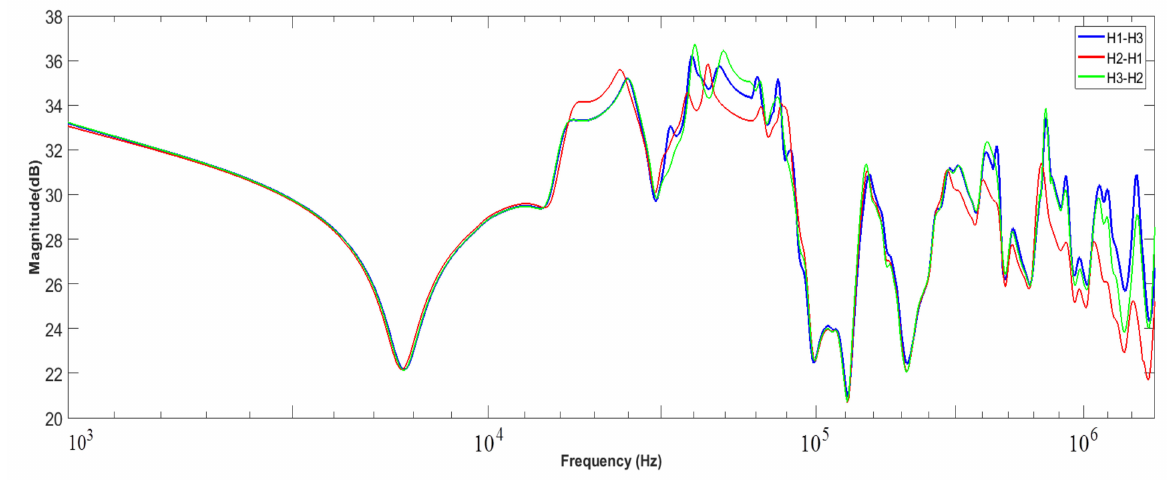
Figure 17. Frequency response of the HV winding for the transformer of steel mill 2.